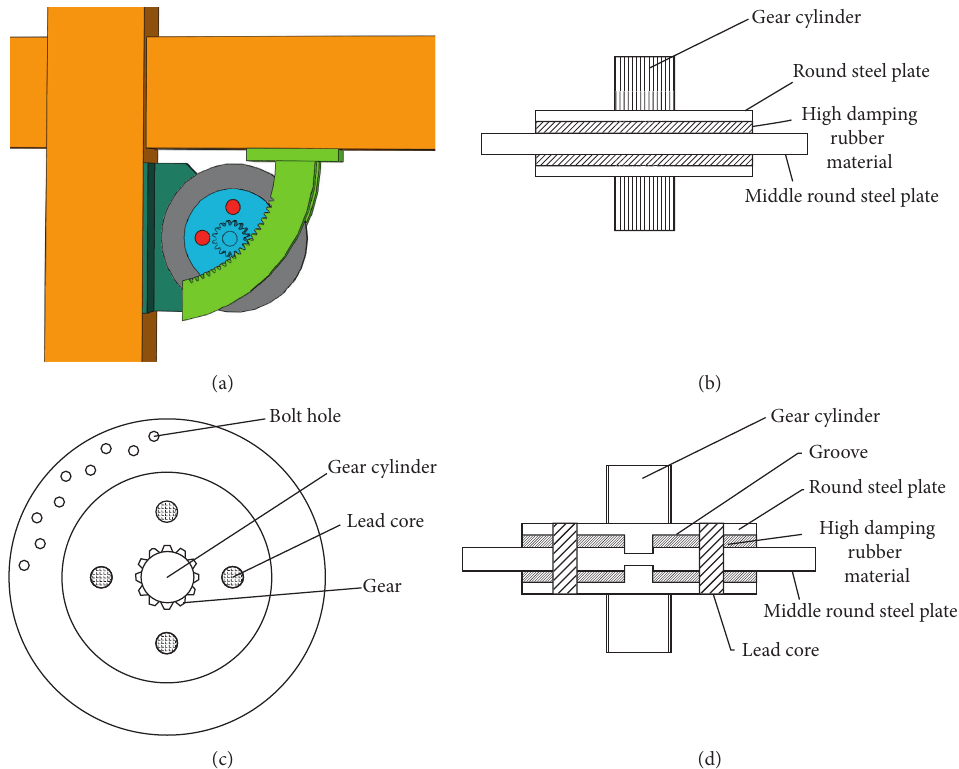
Figure 1: Drawings of the proposed DATD: (a) 3D view of the installation. (b) Elevation drawing. (c) Plan drawing. (d) Section